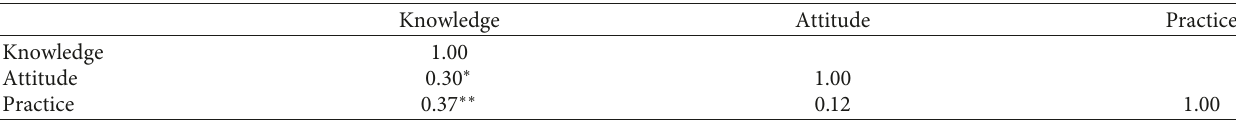
Table 3: Pearson correlation coefficients showing the relationship between caregivers’ KAP regarding prevention and care of PIs. Knowledge Attitude Practice